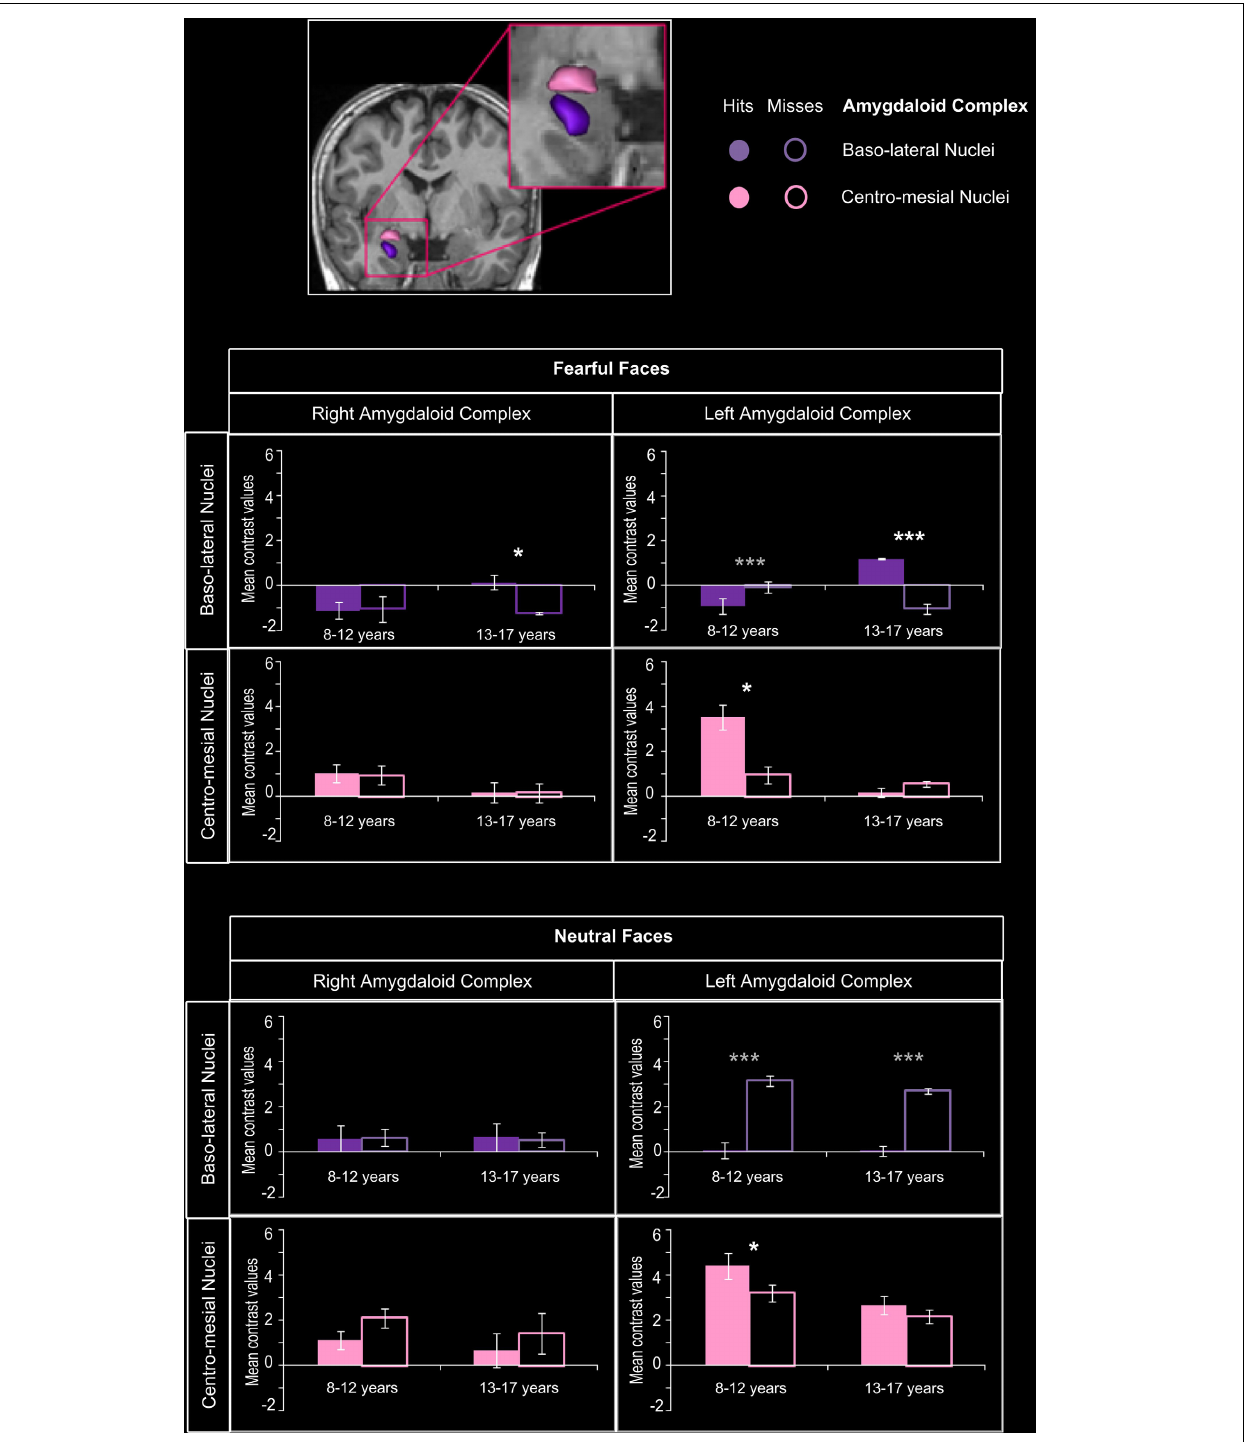
subsequent memory effect was found in centro-mesial nuclei of left AC for fearful( p = 0 . 0027)andneutralfaces( p = 0 . 0034),butnosucheffectwasseen in baso-lateral nuclei. Inversely, in the 13–17 years group, baso-lateral nuclei on both sides were specifically sensitive to fearful subsequent memory effects (right: p = 0 . 0034; left: p < 0 . 00004), whereas no significant effect was found for neutral faces in AC